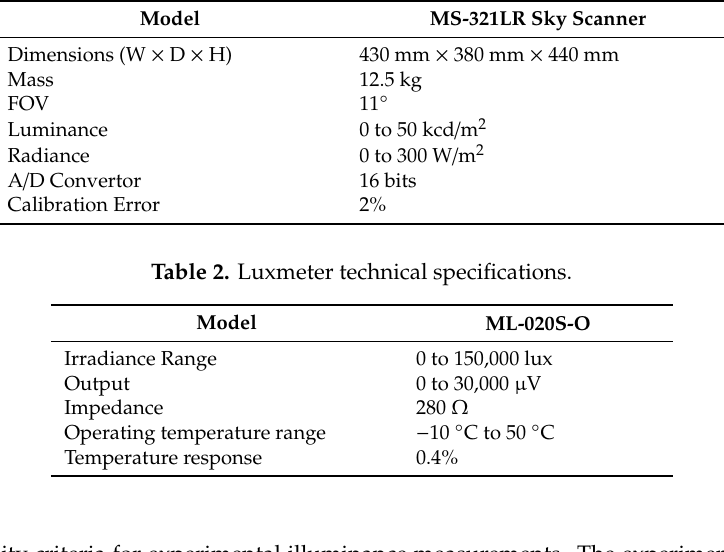
Table 3. Quality criteria for experimental illuminance measurements. The experimental data were discarded if any of the following conditions were met. L 0 is the luminous solar constant (133.8